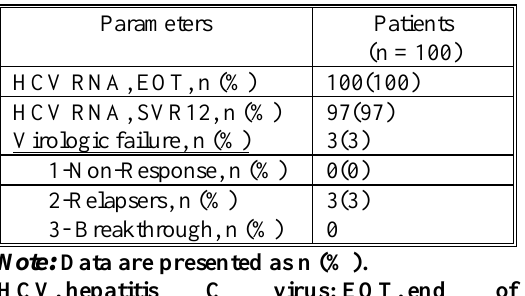
Table 2. Virological response (by modified intention-to-treat (mITT)